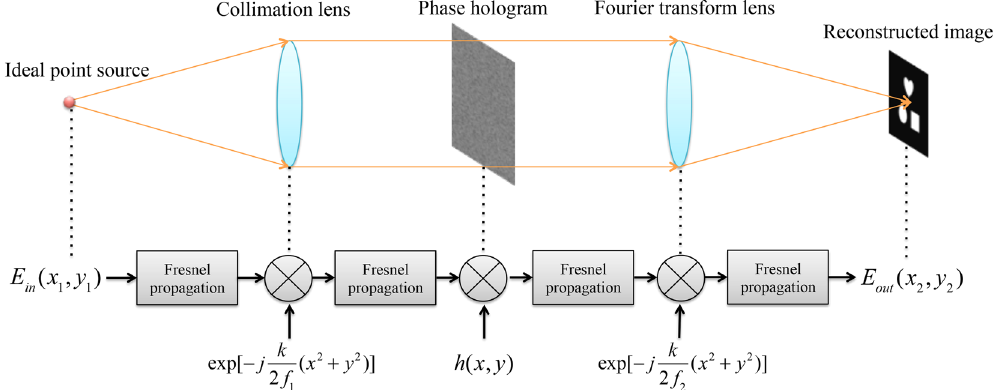
Figure 2. Illustration of a holographic display system with a single monochromatic point source and light propagation through different